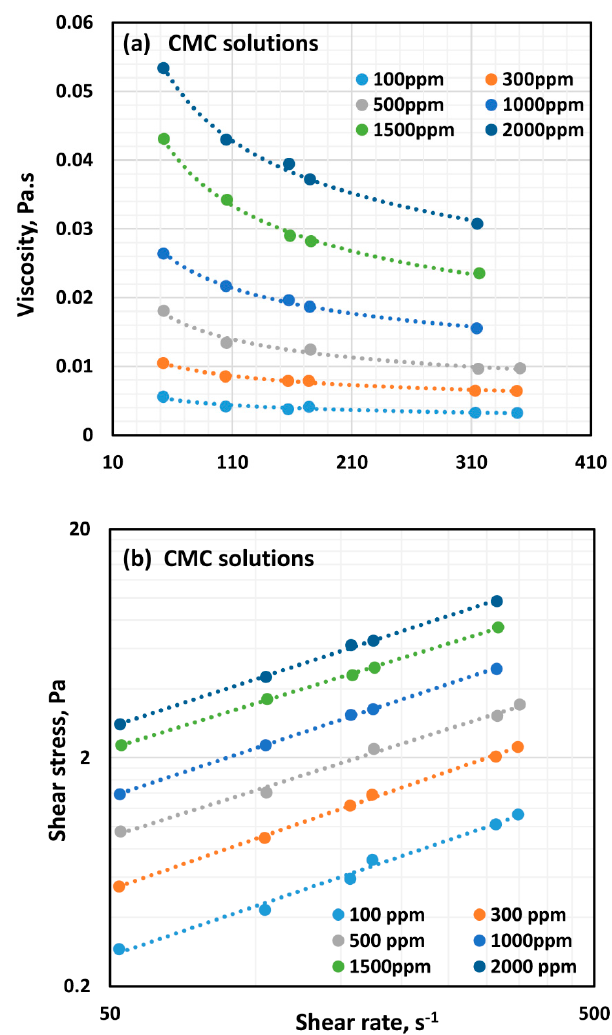
Figure 2. Flow curves for solutions of anionic polymer CMC at different polymer concentrations: ( a ) Viscosity versus shear rate and ( b ) Shear stress versus shear rate.